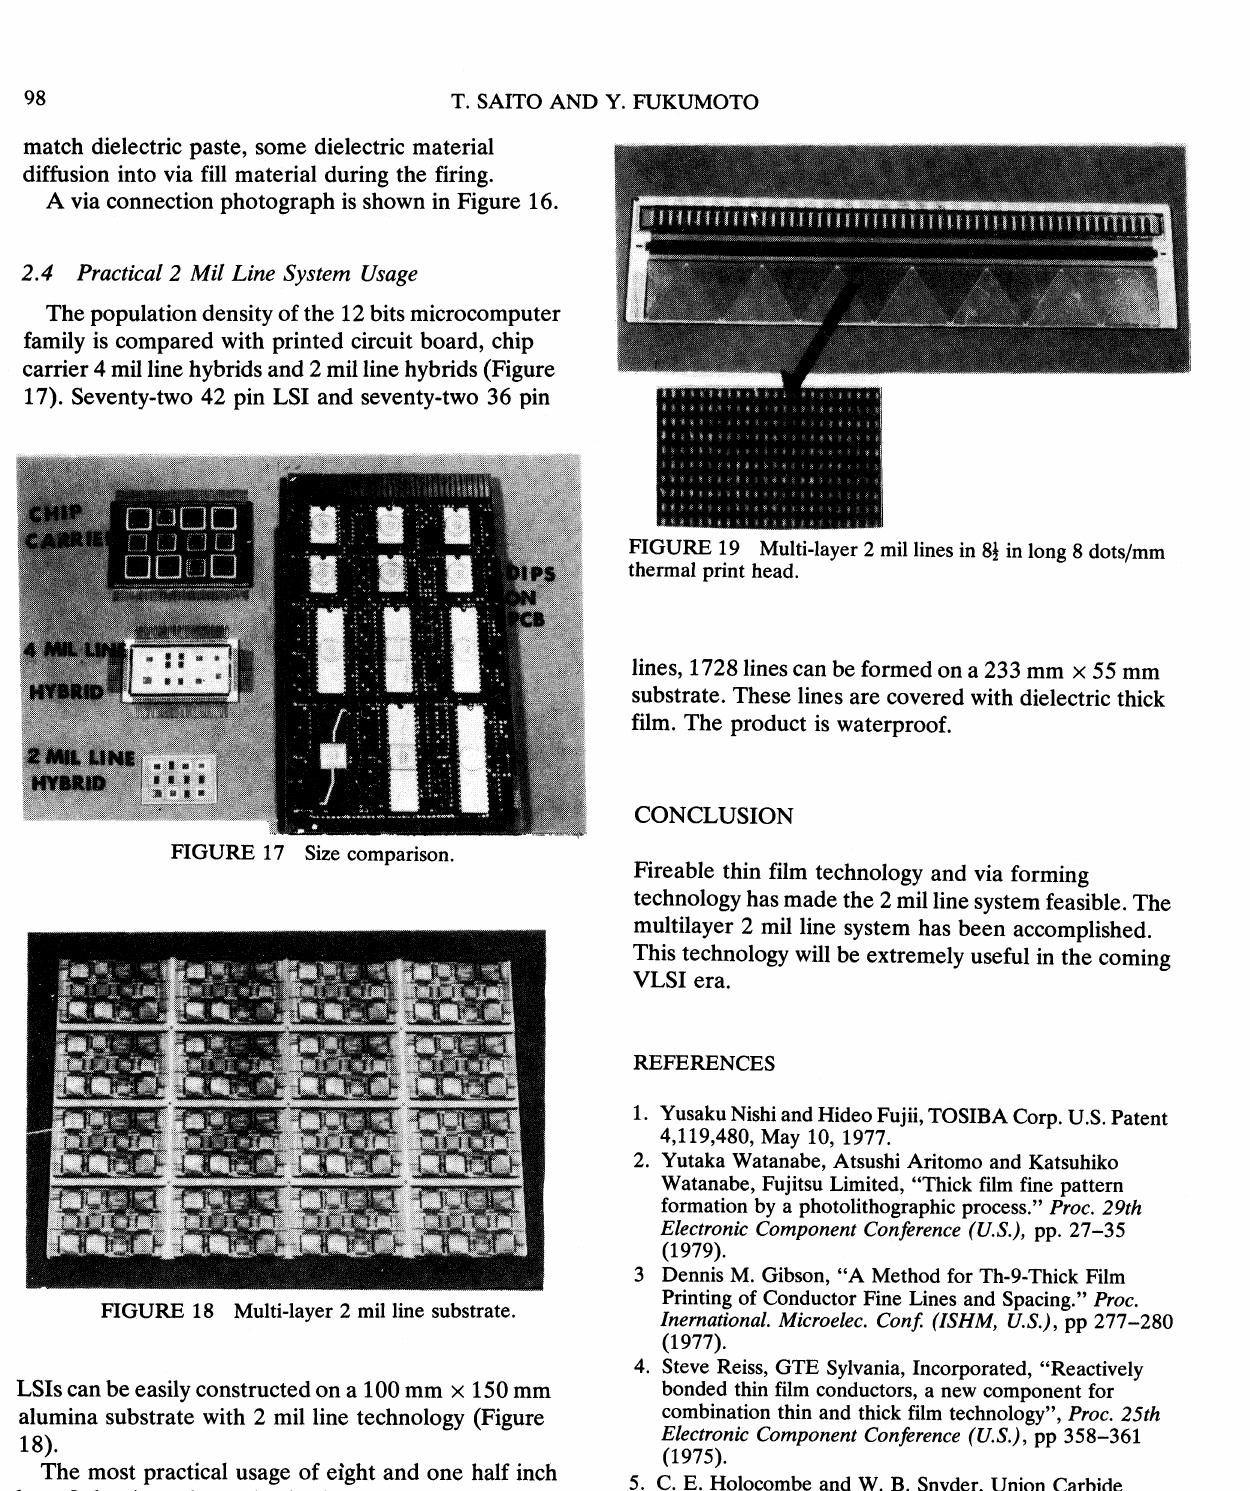
FIGURE 18 Multi-layer 2 mil line